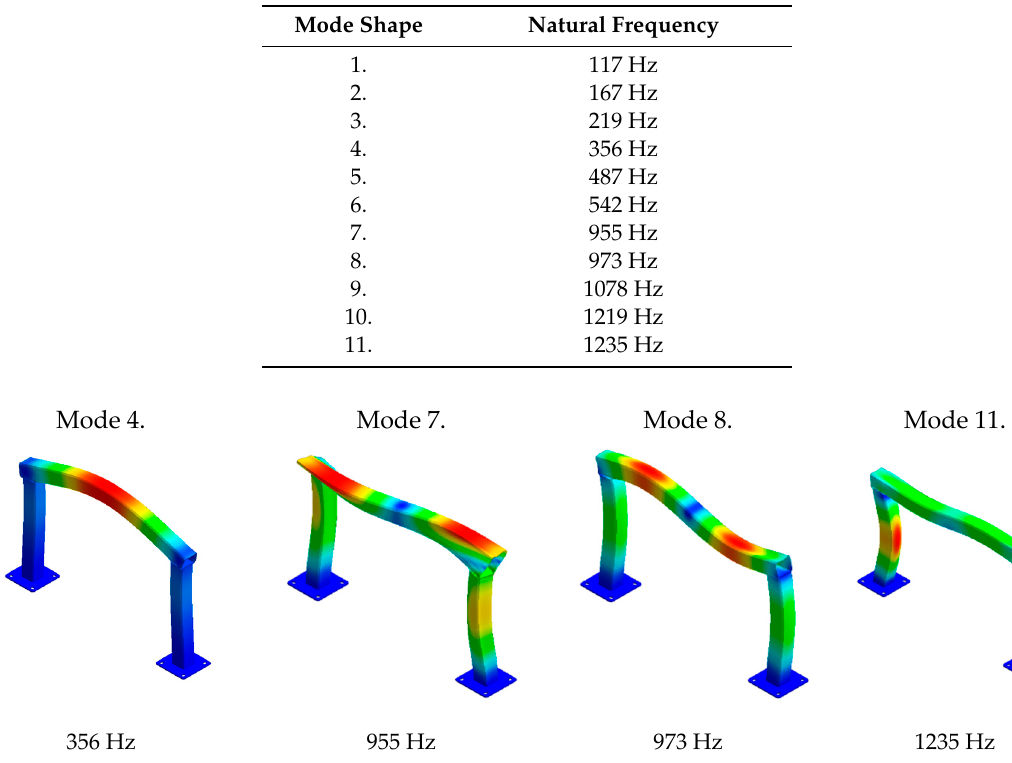
Table 6. Natural frequency values of the steel frame.